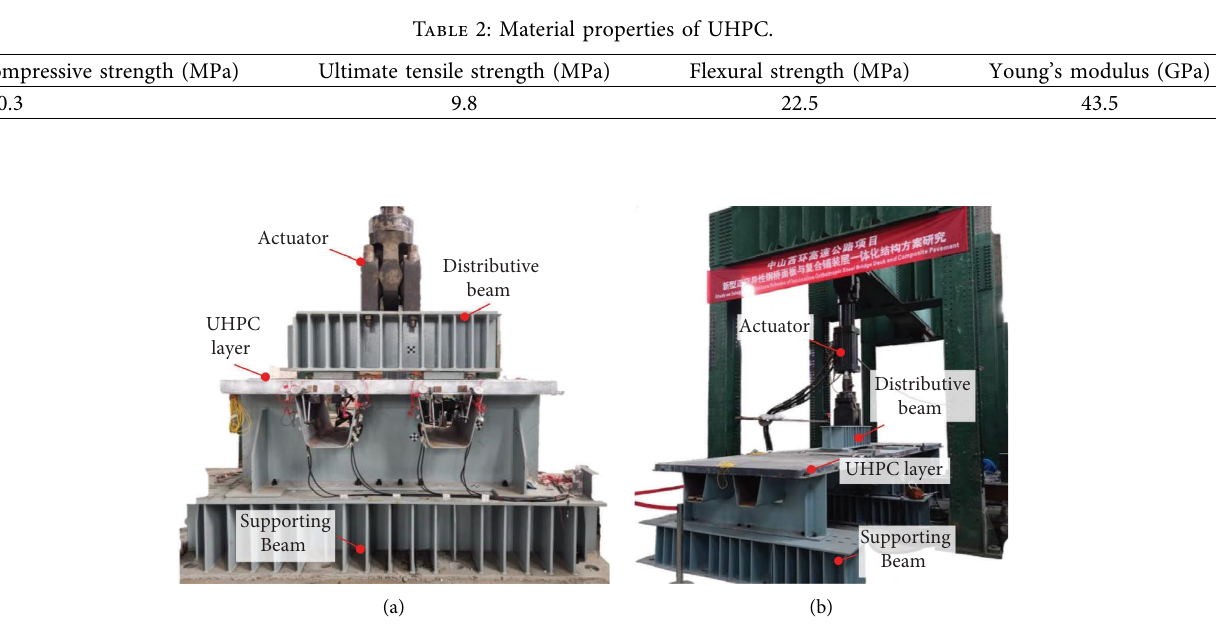
Figure 6: Experimental setup: (a) transverse specimen; (b) longitudinal